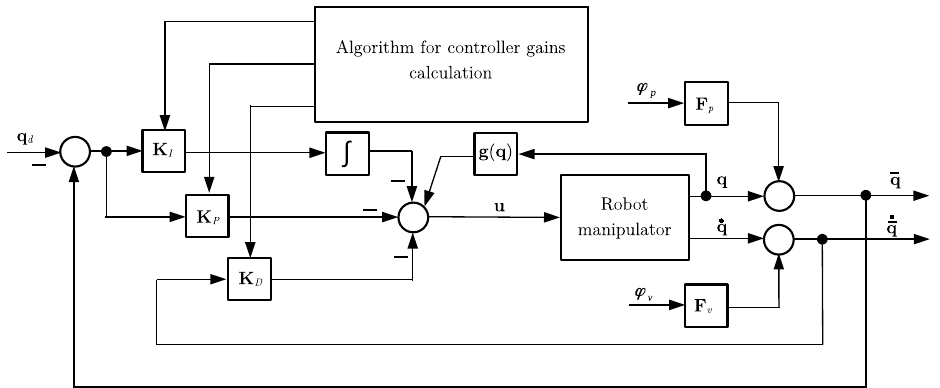
Figure 1. Block diagram of closed-loop system, with algorithm for controller gains